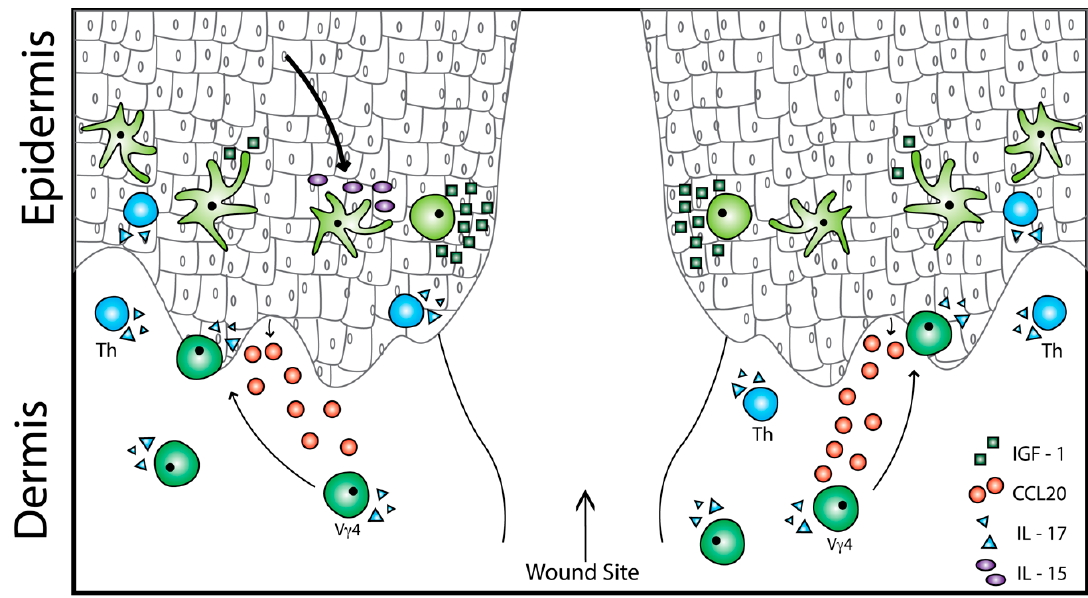
Figure 1. Typical cellular crosstalk occurring in murine wound repair. During wound repair, interleukin-15 (IL-15) is secreted by keratinocytes to activate epidermal γδ T cells to release insulin-like growth factor-1 (IGF-1) and prevent keratinocyte apoptosis. Chemokine ligand 20 (CCL20) is released by keratinocytes to recruit dermal γδ T cells expressing IL-17A and induce local inflammation. IL-17A is also released by epidermal γδ T cells to activate proliferation, differentiation, and migration of keratinocytes.